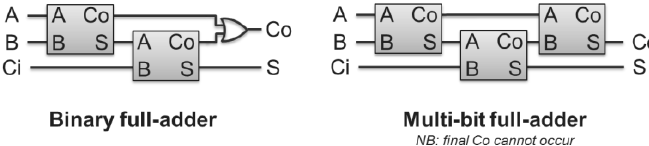
Figure 20. A binary full-adder from half-adders, using an additional OR gate ( left ); the equivalent for multi-bit data ( right ).